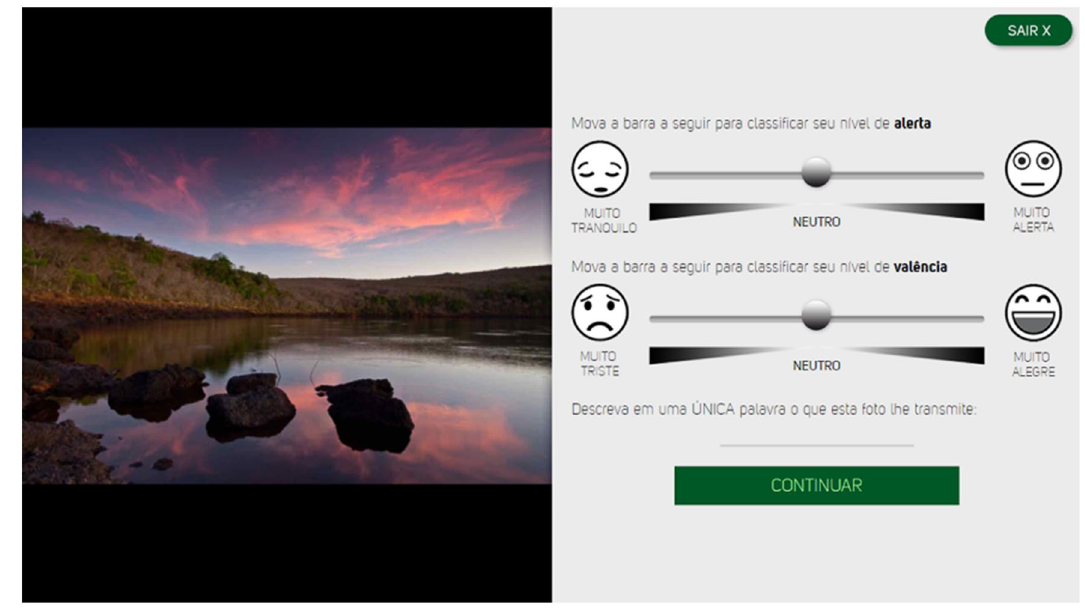
Figure 1. Screenshot showing the digital self-assessment tool designed for rating pictorial stimuli. Participants assigned valence (ranging from very unhappy to very happy) and arousal (ranging from very relaxed to very excited) ratings using the continuous sliders. Portuguese version only, assessments were provided by Brazilian